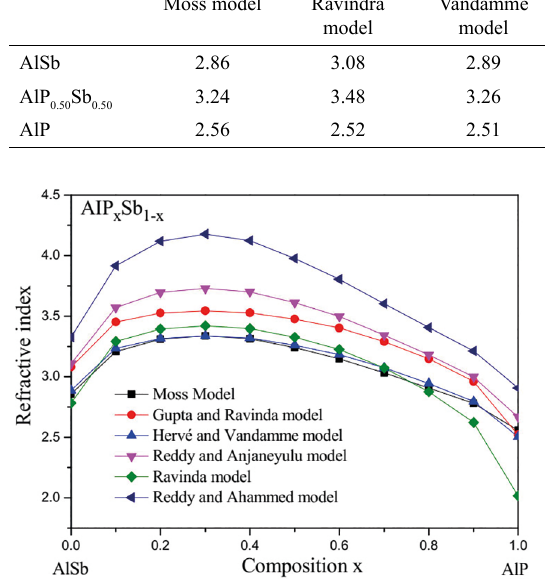
Sb ternary alloys versus P x 1-x